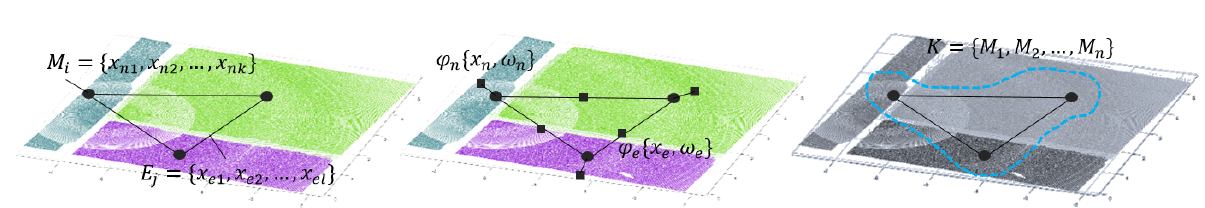
Figure 3 . Overview workflow Clustering. Graph representation (left), Conditional Random Field representation (mid) and the clustered segments